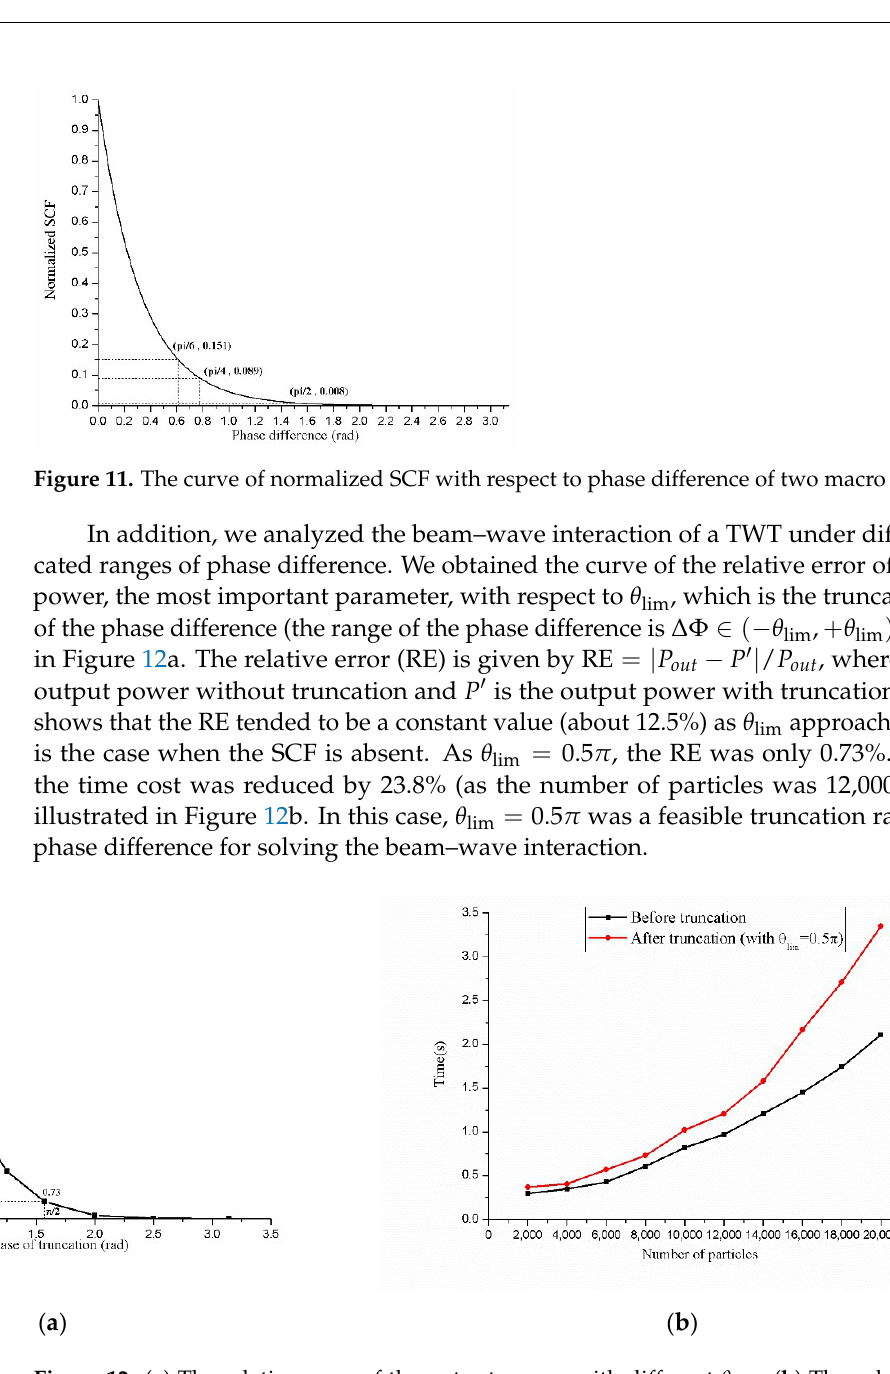
. ( b ) The calculation time lim